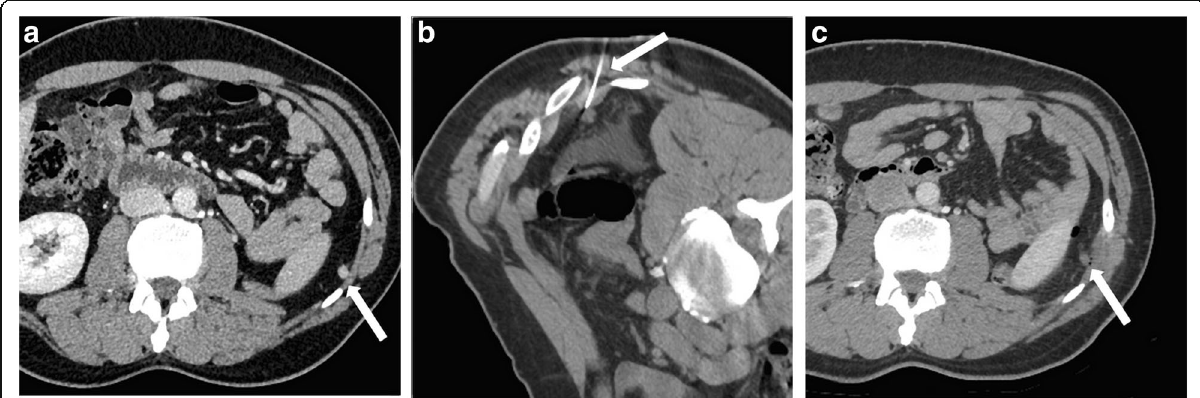
Fig. 1 Forty-two-year-old male patient with small left recurrence of renal cell carcinoma. a Contrast-enhanced computed tomography (CT) scan before treatment. A pathological nodule of 8 mm is clearly visualised in the left kidney fossa (white arrow). b Unenhanced CT scan with the patient placed in a prone position. Laser ablation procedure: the needle of the laser device is clearly seen placed insight the pathological nodule during the treatment (white arrow). c Contrast-enhanced CT scan after treatment. The small pathological nodule does not show any contrast uptake demonstrating the effectiveness of the treatment (white arrow)